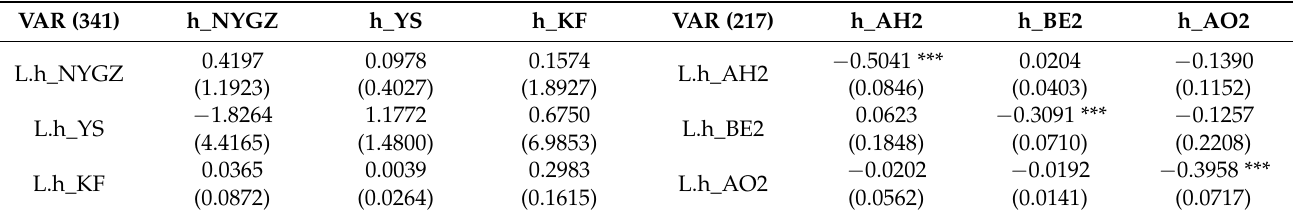
Table 7. GMM estimation results of PVAR model (lag 1